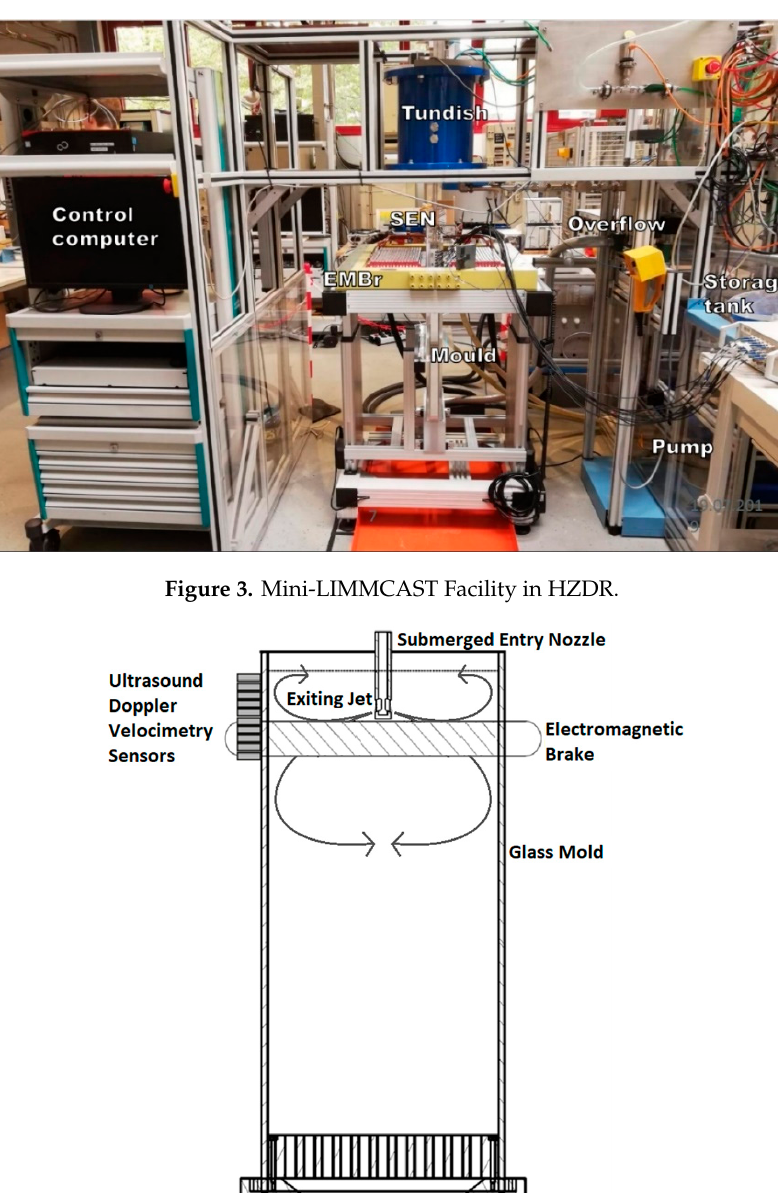
Figure 3. Mini-LIMMCAST Facility in HZDR.